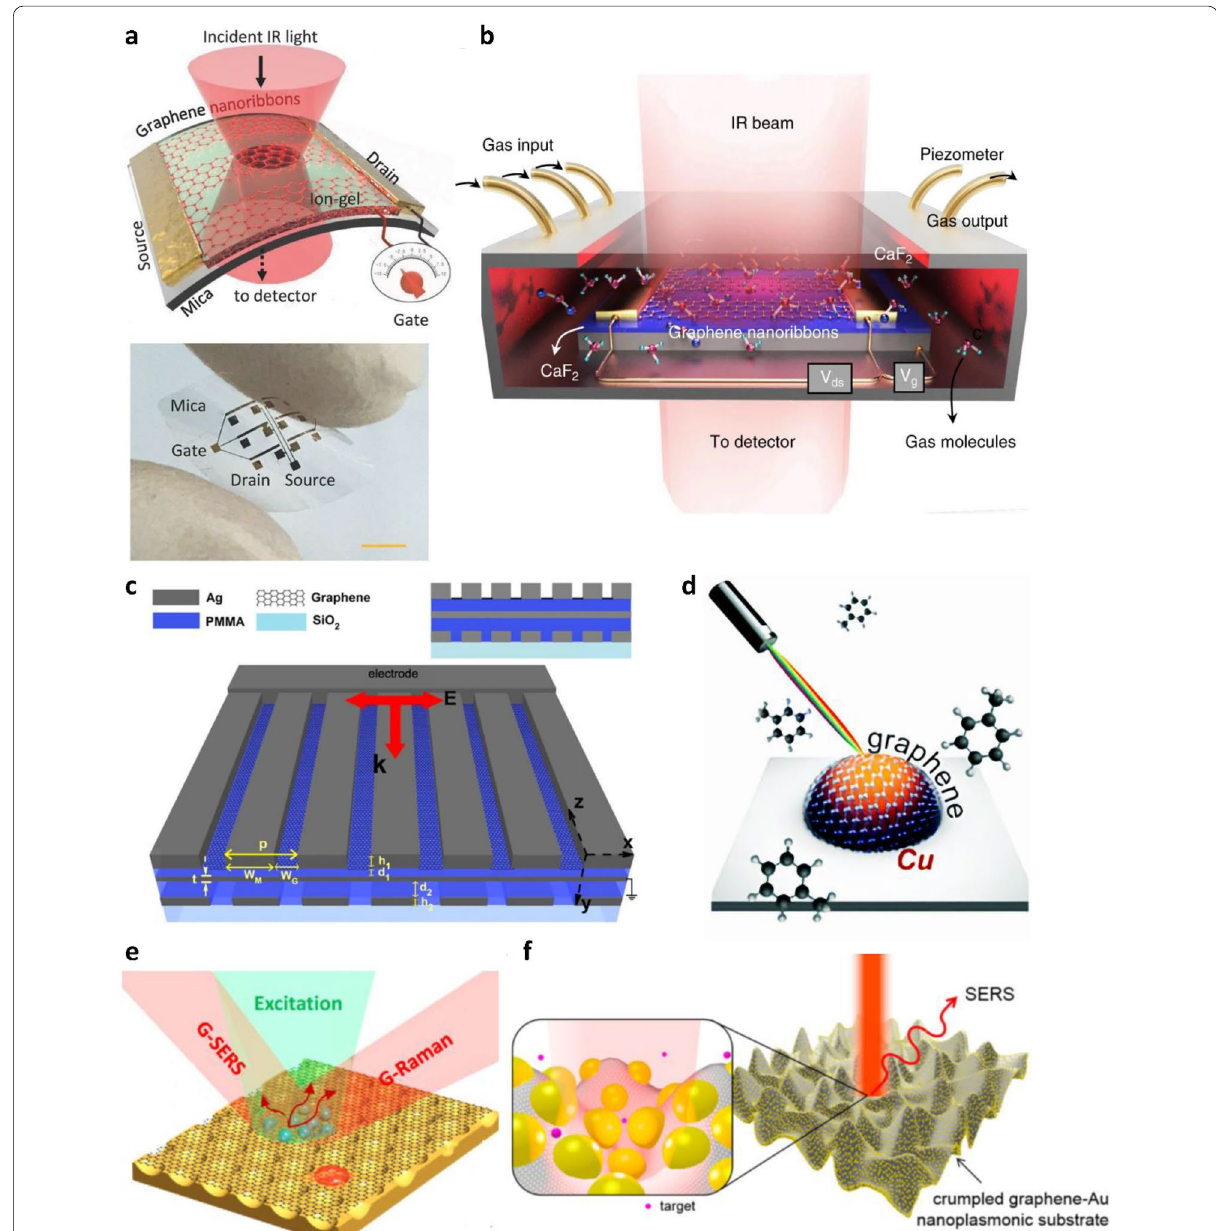
Fig. 8 Graphene based plasmonic sensors for chemical sensing. a Plasmon excitation and detection with flexible graphene-mica plasmonic device for ion gel. Reproduced with permission from [14]. Copyright 2018 The Authors. Published by WILEY-VCH Verlag GmbH & Co. KGaA, Weinheim. b Graphene nanoribbon plasmonic gas sensor. A metal gas chamber with a piezometer was used for the precise control of gas parameters. Reprinted under the terms of the Creative Commons License from [15]. Copyright 2019 The Authors. Published by Springer Nature. c Ag nanoribbon-graphene hybrid structure on a PMMA/Ag/PMMA substrate for gas sensing. Reprinted under the terms of the Creative Commons License from [124]. Copyright 2016 The Authors. Published by Springer Nature. d Schematic illustration of local plasmonic resonance sensor based on graphene encapsulated copper nano-island. Republished with permission of Royal Society of Chemistry from [118]. Copyright 2020; permission conveyed through Copyright Clearance Center, Inc. e SERS sensor based on graphene-Au nanovoids. Reproduced with permission from